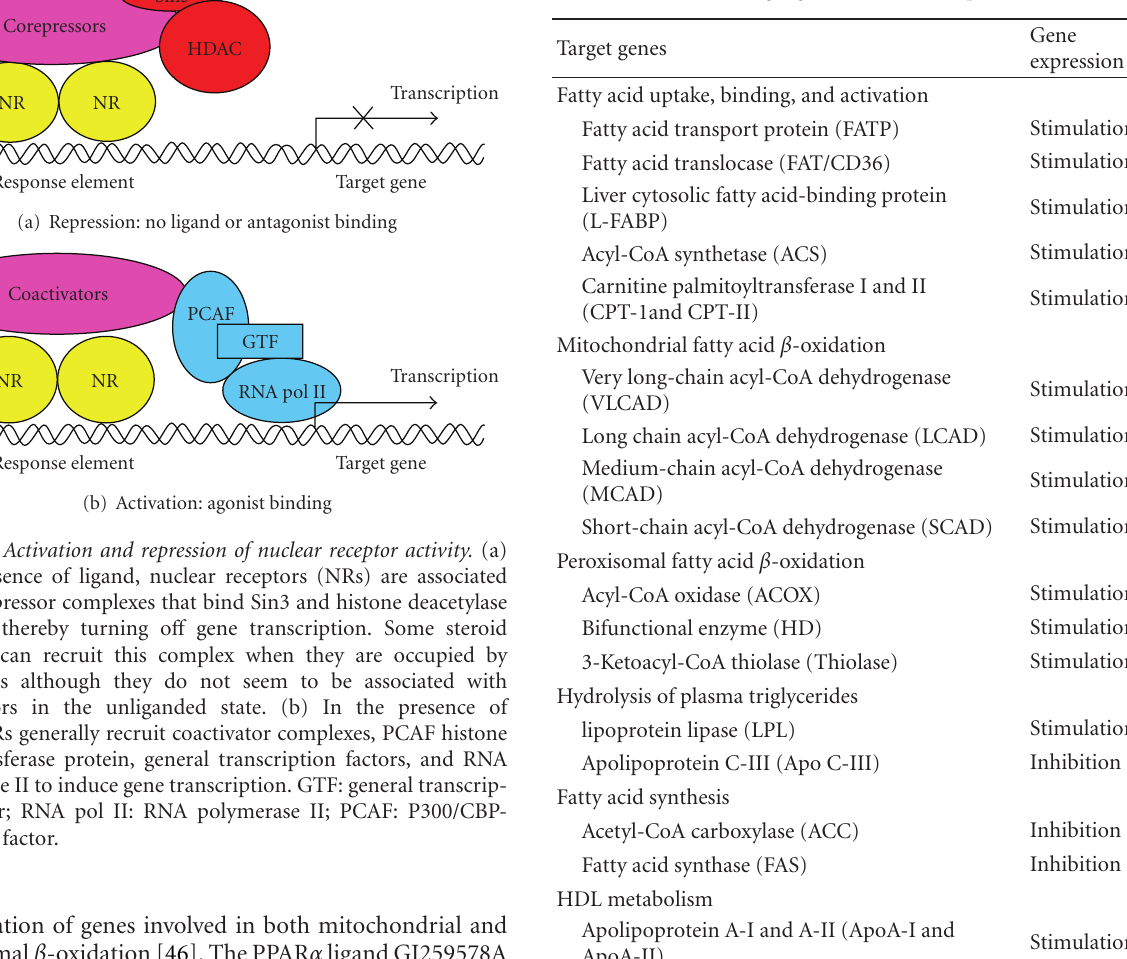
Table 1: PPAR α target genes involved in lipid